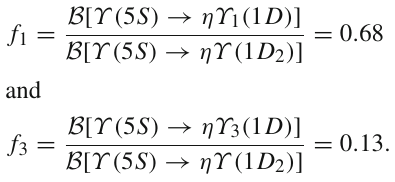
order of 10 − 3 , and precise predictions for the contributions due to the three components of the 1 D triplet are